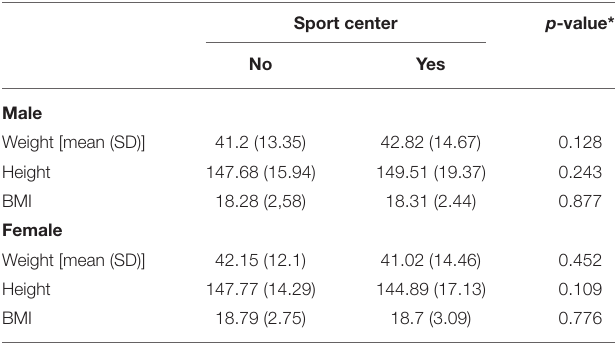
TABLE 2 | Differences by gender of the mean values of weight, height and BMI of children differentiated by attendance or not at sports clubs. Sport center p